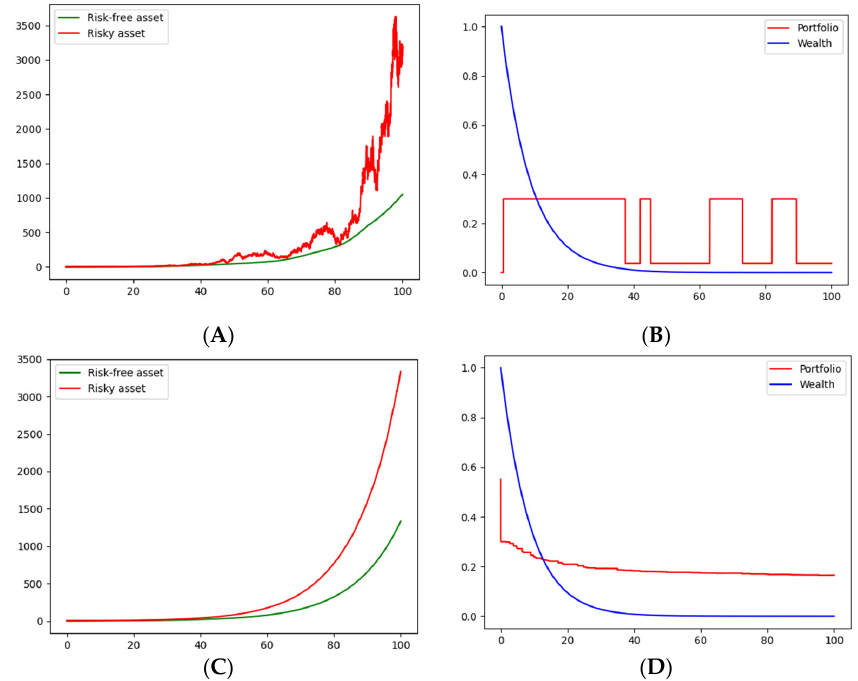
Figure 2. First scenario, CRRA utility, a 0 = r 0 = S 0 = X 0 = 1, Natural momentum ( µ 1 = 0.12, r 1 = 0.08, σ 1 = 0.2 ) vs. inferred momentum ( µ 2 = 0.06, r 2 = 0.055, σ 2 = 0.2 ) , with ρ = 0.12, γ = 1/3 and g = constant. ( A ) Price realization, ( B ) Portfolio strategy, ( C ) Average of price realizations, and ( D ) Average of portfolio strategies. Authors’ own elaboration.